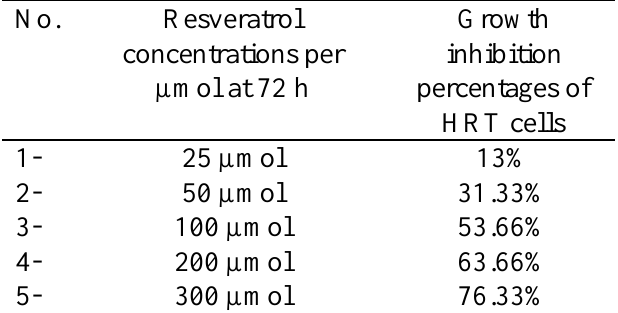
Table 1. Growth inhibition effect of resveratrol in different concentrations in HRT colon cancer cell